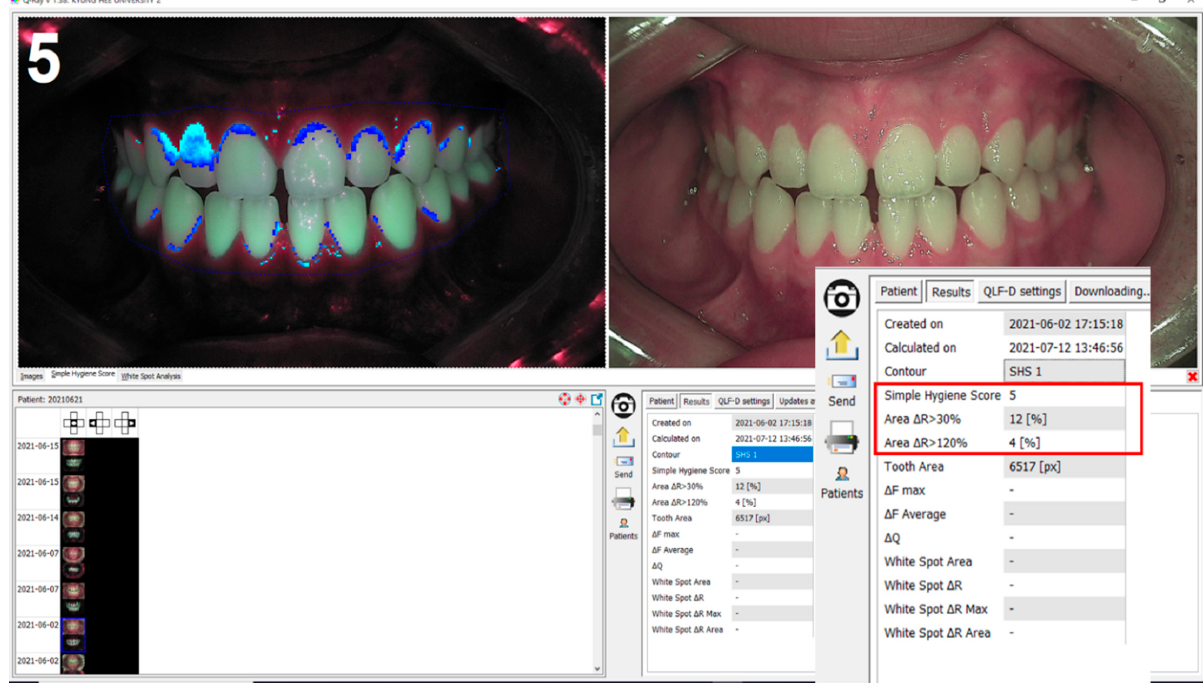
Figure 3. FPI score is automatically calculated with the “Simple Hygiene Score” function of the proprietary analysis program (Q-ray version 1.24, Inspektor Research Systems BV, Amsterdam, The Netherlands).